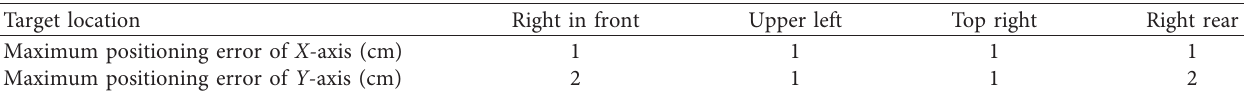
Table 9: Regulatory